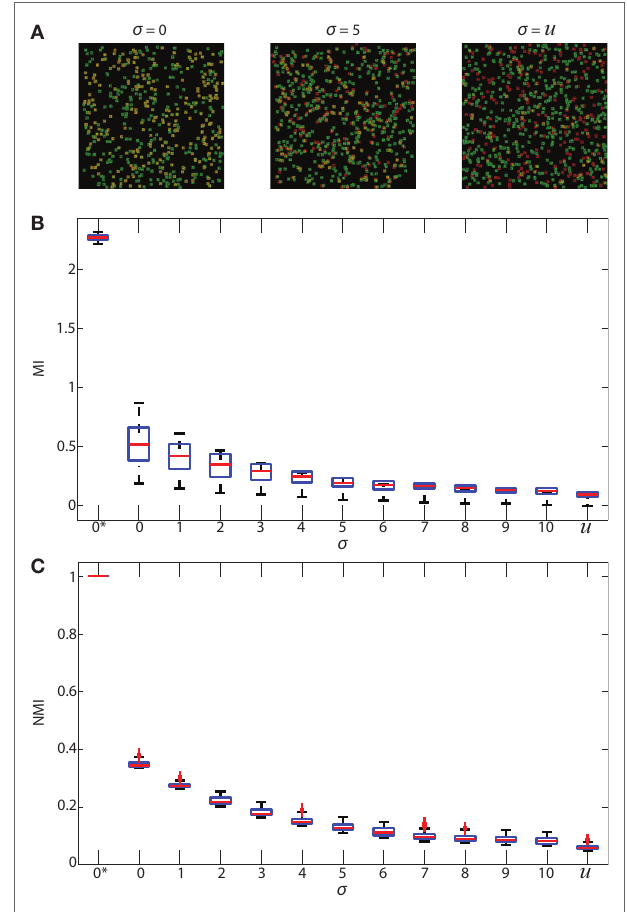
FigUre 3 | Validation of MI and NMI. Panel (a) shows 3 samples of simulated 512 × 512 images that consist of 500 green cells and a number of red cells uniformly distributed between 100 and 500. Each pixel intensity of the red and green cells is randomly assigned, and each cell is a square of 11 × 11 pixels. The red cell locations are chosen from a Gaussian distribution centered at the location of green cells with SD ( σ ) 0 and 5 in the first and second images, and uniformly random in the third image. (B) shows boxplots of MI in bits and (c) shows boxplots of NMI (unitless) of simulated images where the SD ( σ ) ranges from 0 to 10. 2 additional special cases are shown: 0* and u . 0* indicates that red and green color intensities are identical in corresponding locations which maximizes both MI and NMI. u indicates that the cells are placed uniformly at random within the image and with uniform random color intensity, resulting in the lowest MI and NMI. Increasing σ decreases the spatial association of cells. As spatial association decreases, and both MI and NMI systematically decrease, demonstrating that they are useful metrics that indicate spatial association between